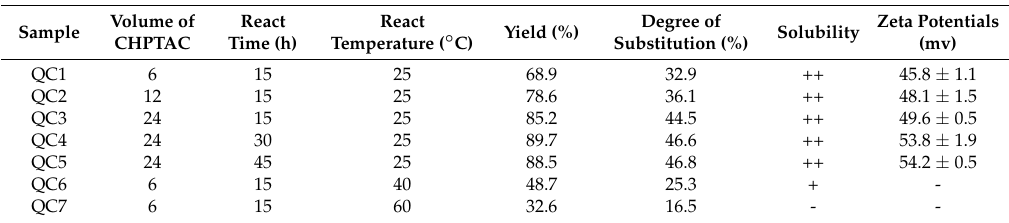
Table 1. The reaction conditions, yields, degree of substitution (DS), solubility and zeta potentials of quaternized chitosans